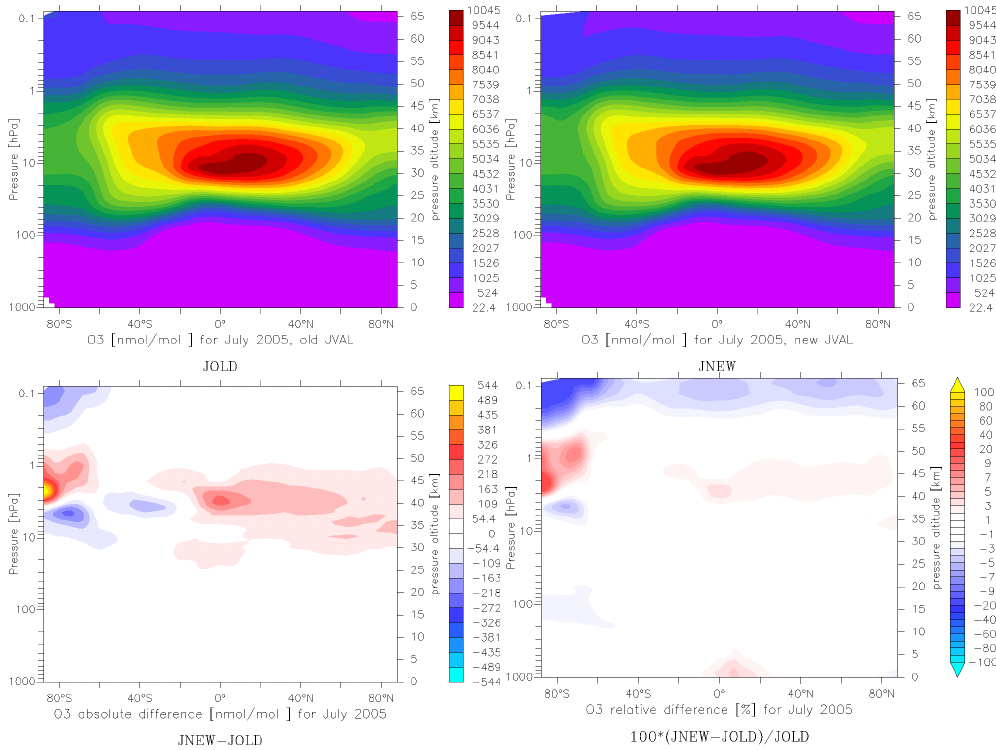
Figure 4. Effect of updated J values on ozone. All plots refer to zonally averaged monthly mean values of July 2005.